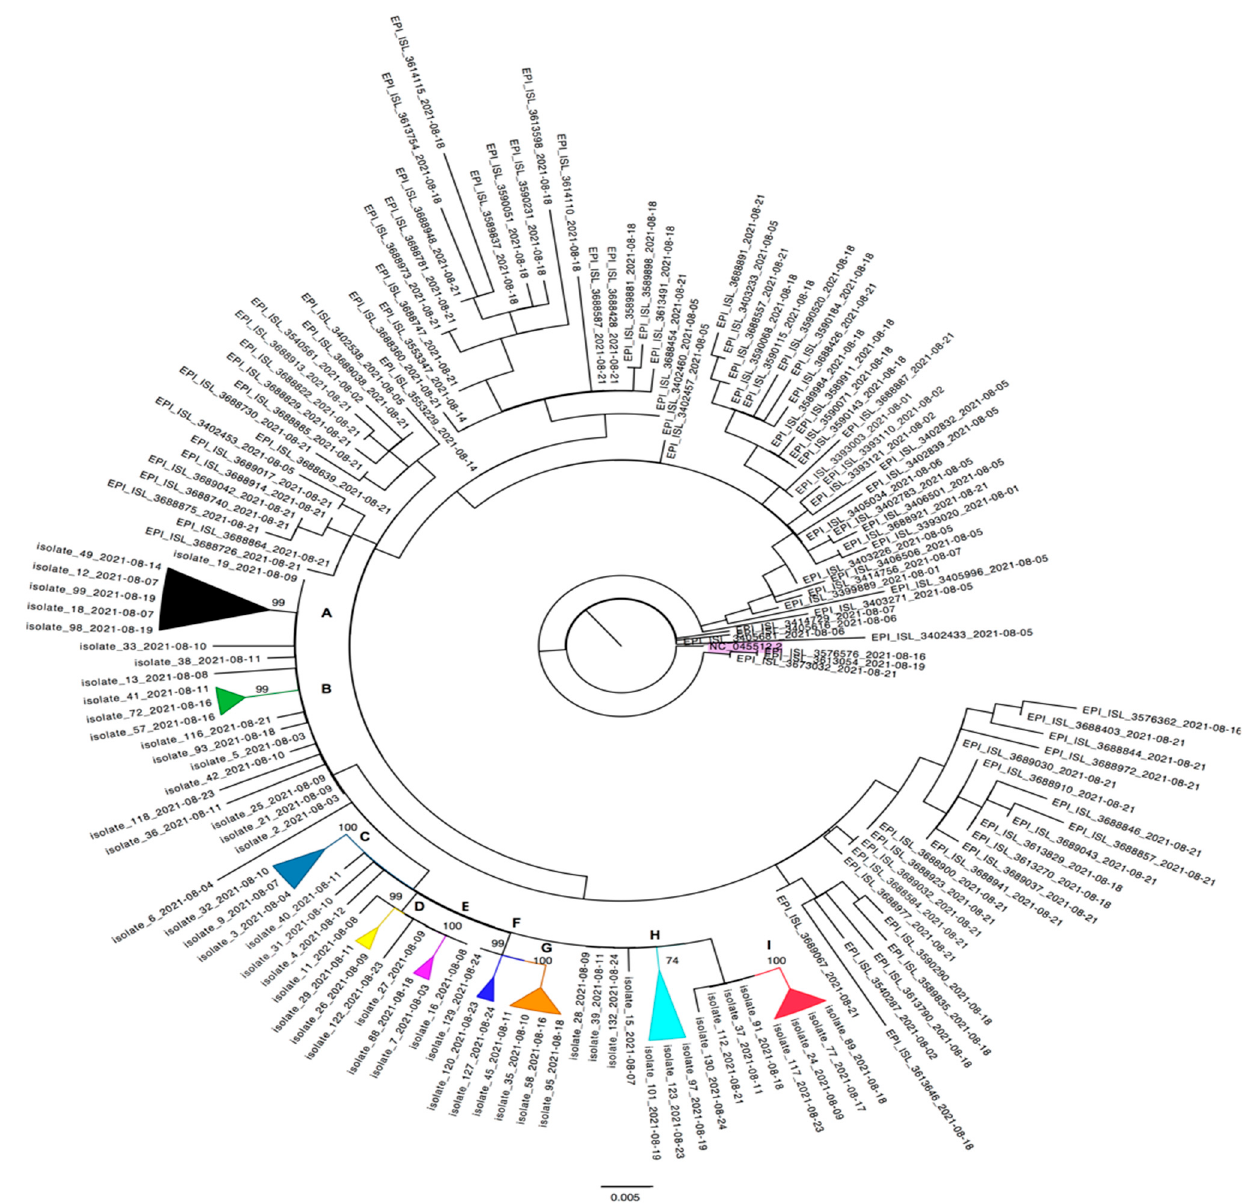
Figure 2. ML phylogenetic tree was estimated using 99 sequences from Turkey and 58 SARS-CoV-2 newly generated sequences. The tree was rooted by the midpoint rooting according to the NC_045512.2 (highlighted in purple) outgroup sequence. The reliability of the phylogenetic clustering was evaluated using bootstrap analysis with 1000 replicates. Bootstrap support values (>70%) are only shown for the clusters (colored collapsed cartoons) including Kahramanmara ş city isolates. The nine clusters were identified with the alphabetic letters from A to I. The scale bar at the bottom of the figure represents genetic distance (0.005). cluster size of three positive subjects. Thirty out of fifty-eight (51.7%) new isolates did not belong to any cluster, including the two isolates detected in a married couple (#19 and #25